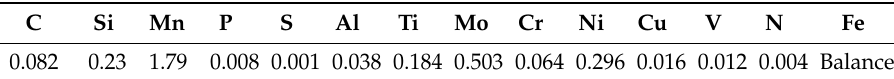
Table 1. The chemical composition of the steel used in the experiments (wt